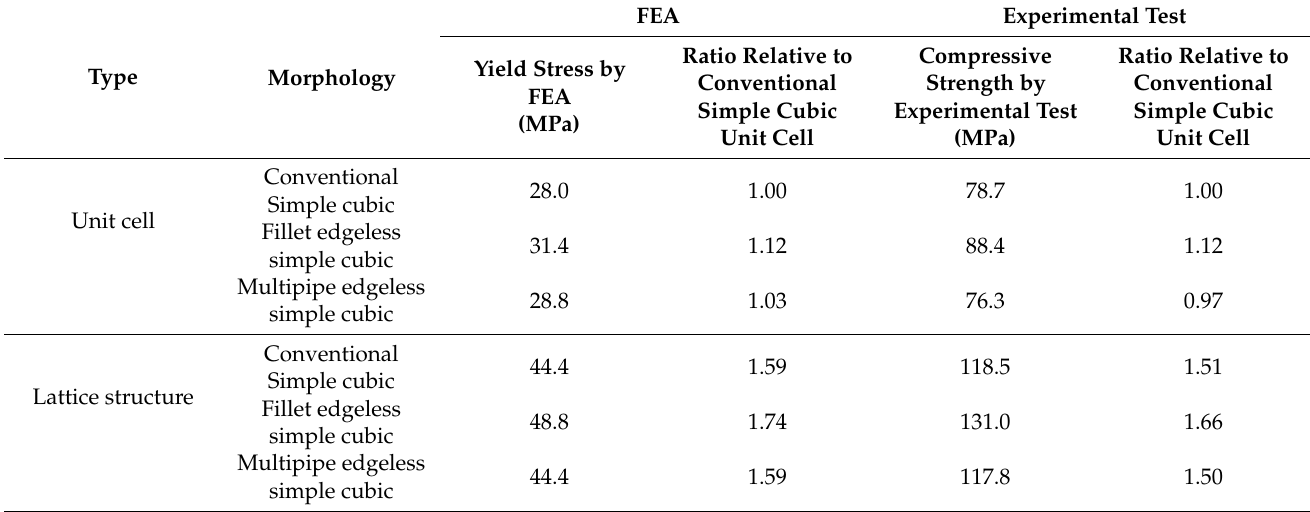
Table 5. Comparison of FEA and experimental